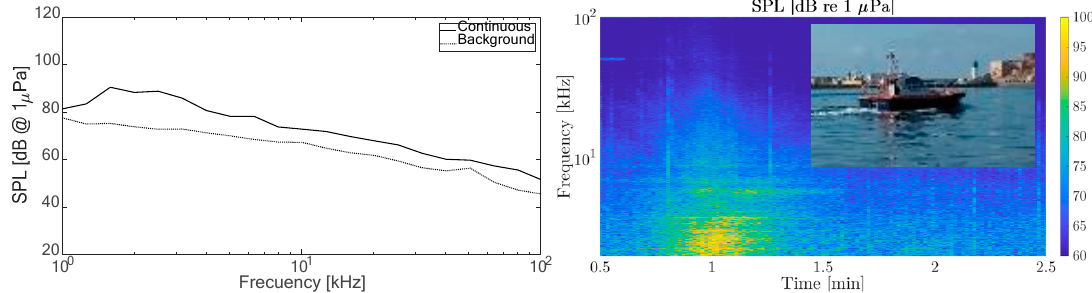
Figure 10. Loading a cargo ship ( left ), and spectrogram of the noise generated ( right ) at P2 in Figure Figure 9. ( left ) Spectrum of continuous noise source. ( right ) Its spectrogram (Point P3).